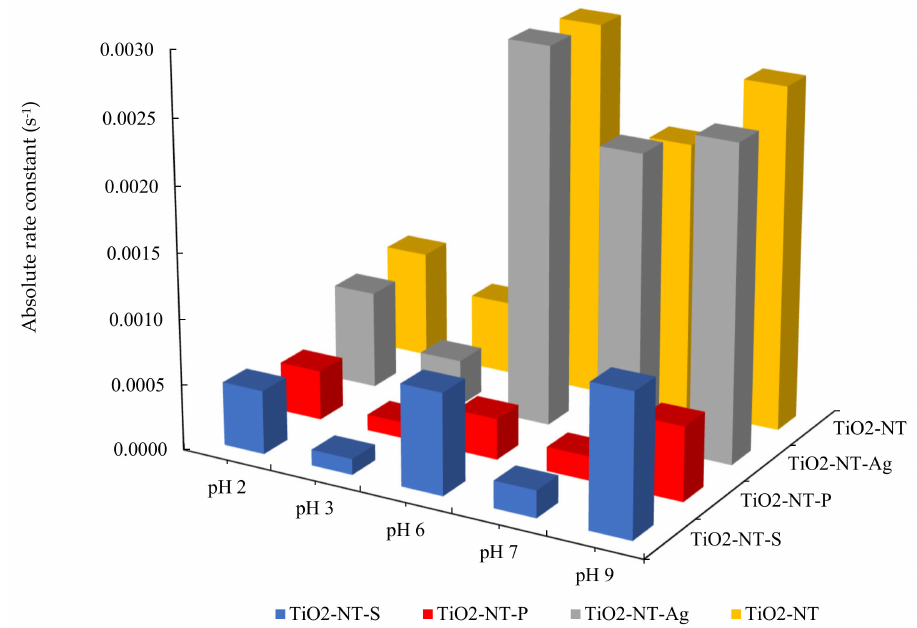
Figure 7. Rate constants for the degradation of tannic acid under di ff erent pH using TiO 2 nanotube layers irradiated with 10 mWcm − 2